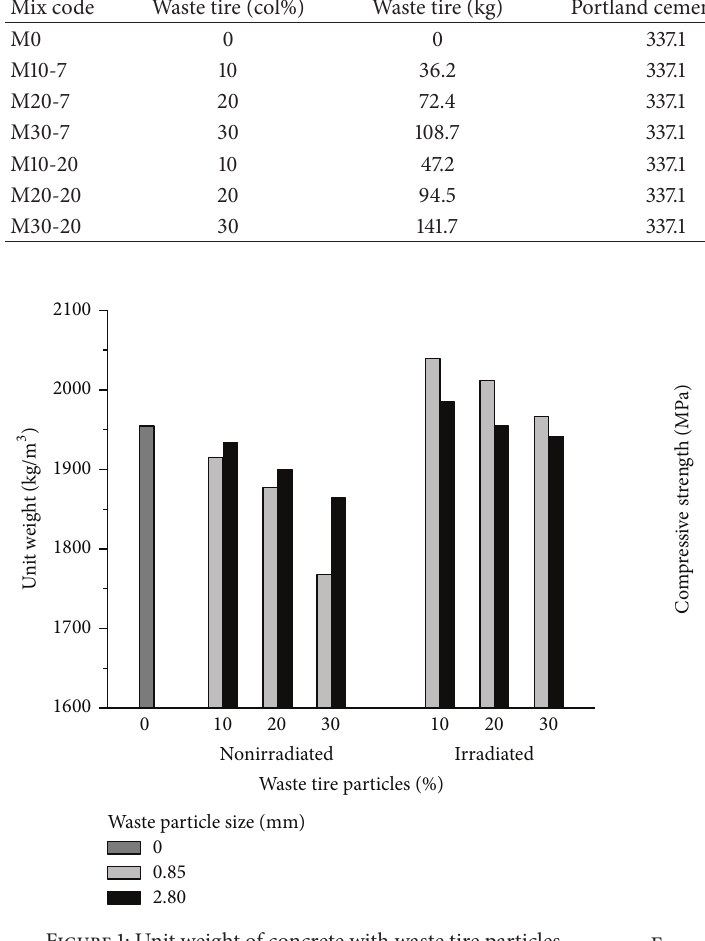
concentration of particles. The values vary from 0.7 to 1.8 MPa; being the highest value for concrete with 10% of particles of 2.8 mm, this value is 6% minor than those for control concrete. (b) Concretes with particles of 2.8 mm have higher values than those with 0.85